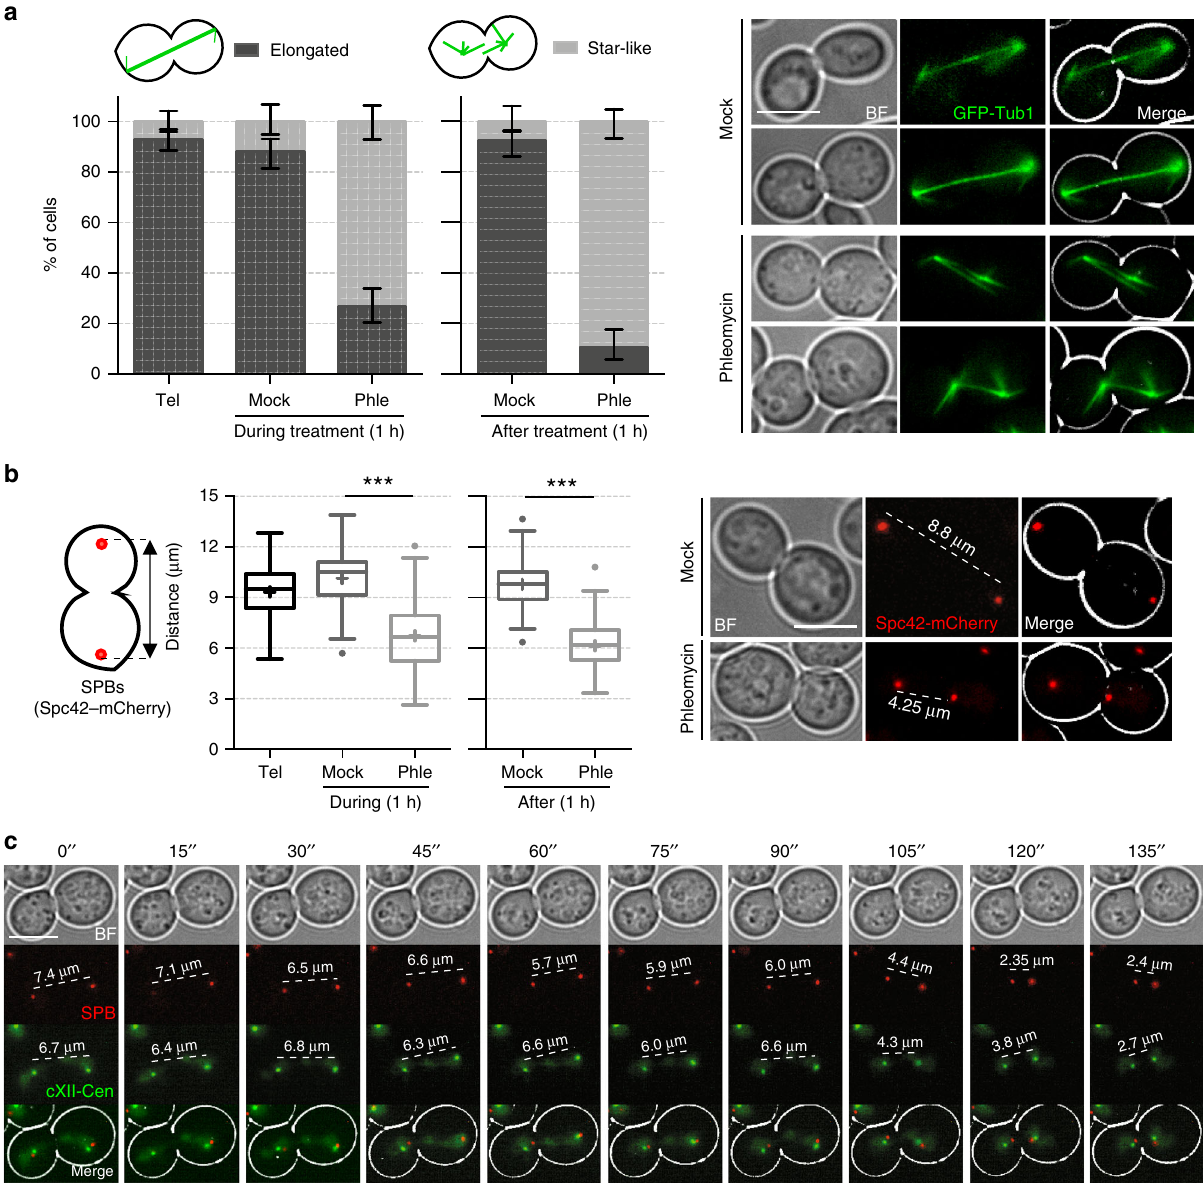
Fig. 5 Dynamics of microtubules after DNA double-strand breaks in telophase. a Microtubules are repositioned after DSBs in telophase. Strain FM2381 was treated as in Fig. 2a. At the indicated conditions, samples were taken and microtubules visualised under the microscope. Two categories were considered for quanti fi cation of the spindle: elongated and star-like; the latter being formed by multiple and shorter microtubule fi bres arising from each SPB (% cells ± CI95, one representative experiment). b SPBs approach each other after DSBs. Strain FM2316 was treated like in Fig. 2a. On the left, box-plots of distances between SPBs under the indicated treatments (*** indicates p < 0.0001; Mann-Whitney U Test). On the right, representative cells for the major phenotypes observed during each treatment. c SPBs often move ahead centromeres during the approximation that follows DSB generation in telophase. Strain FM2316 was treated and fi lmed like in Fig. 3b. Scale: white bars correspond to 5 µ m; BF, bright fi eld. Source data are provided as a Source Data fi